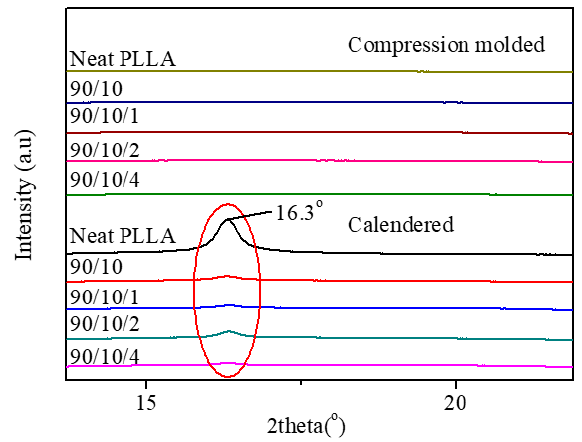
Figure 6. XRD patterns of PLLA and PLLA/EPDM/OMMT (90/10/ x ) samples prepared by compression-molding and